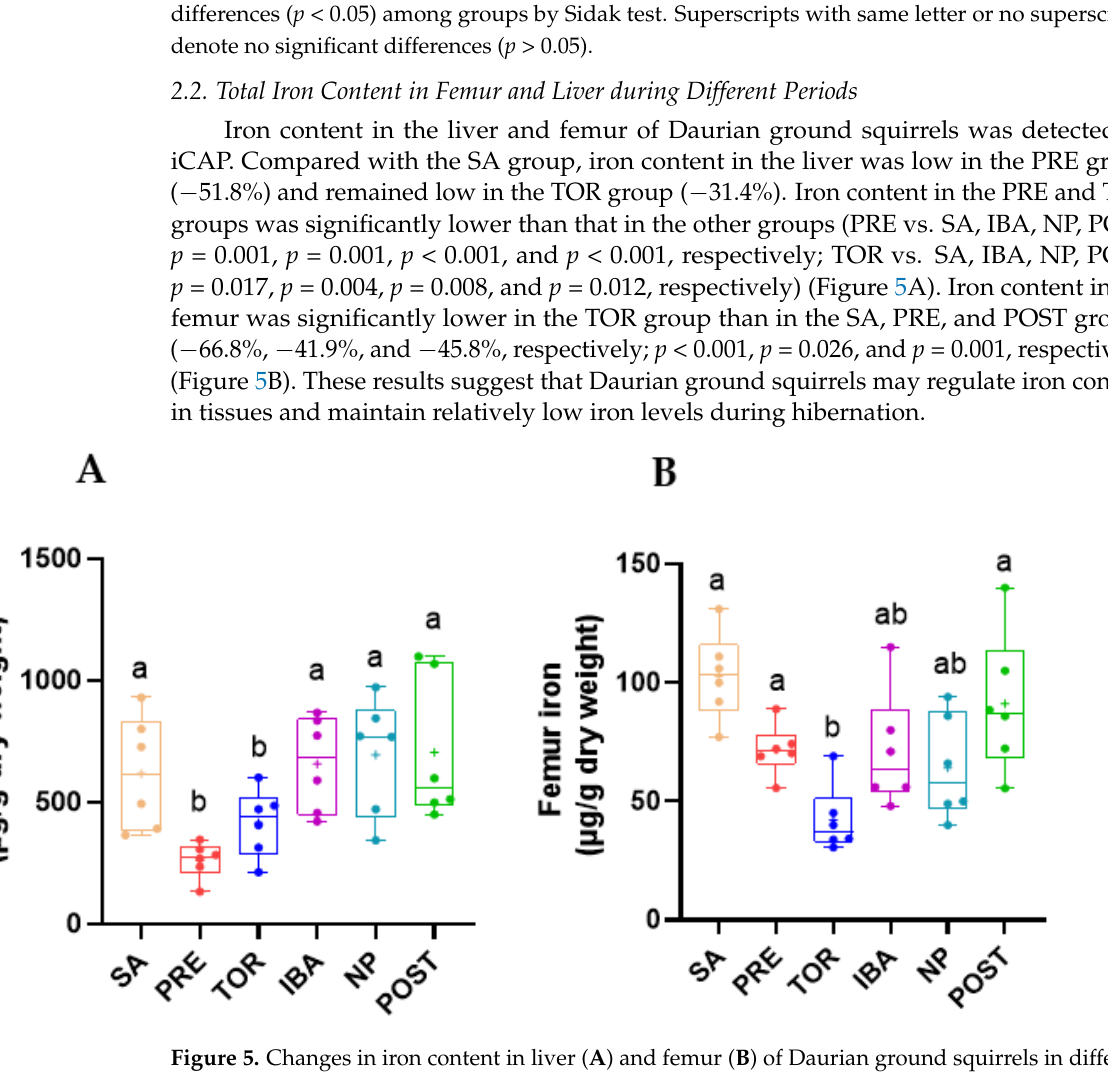
Figure 5. Changes in iron content in liver ( A ) and femur ( B ) of Daurian ground squirrels in different groups. SA, summer active group; PRE, pre-hibernation group; TOR, torpor group; IBA, interbout arousal group; NP, near post-hibernation group; and POST, post-hibernation group. Boxes represent upper and lower quartiles, middle horizontal line represents median, plus sign represents average, lines extending from upper and lower ends represent upper and lower edges, respectively, and points represent individual sample values ( n = 6). Superscripts with different letters indicate significant differences ( p < 0.05) among groups by Sidak test. Superscripts with same letters denote no significant differences ( p > 0.05).